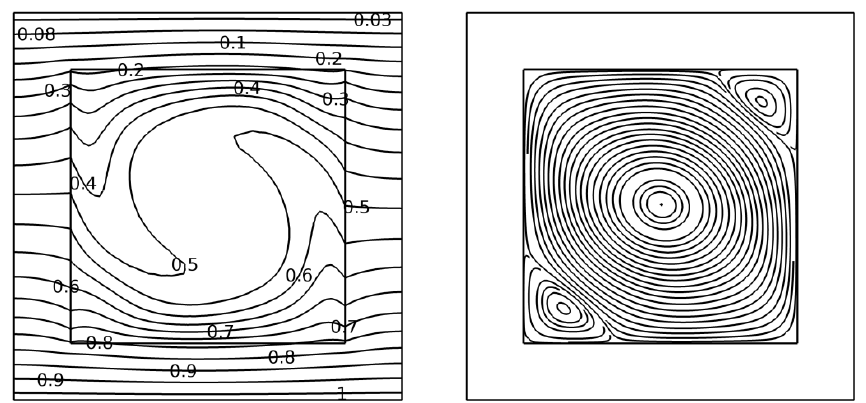
Figure 15. Streamlines and isothermals obtained when heating the bottom, W max = 69.235.